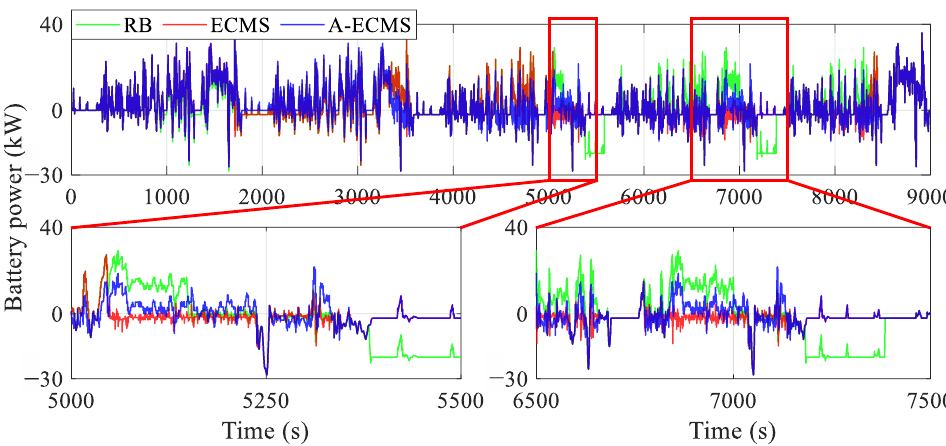
Figure 11. Curves of the battery power using different